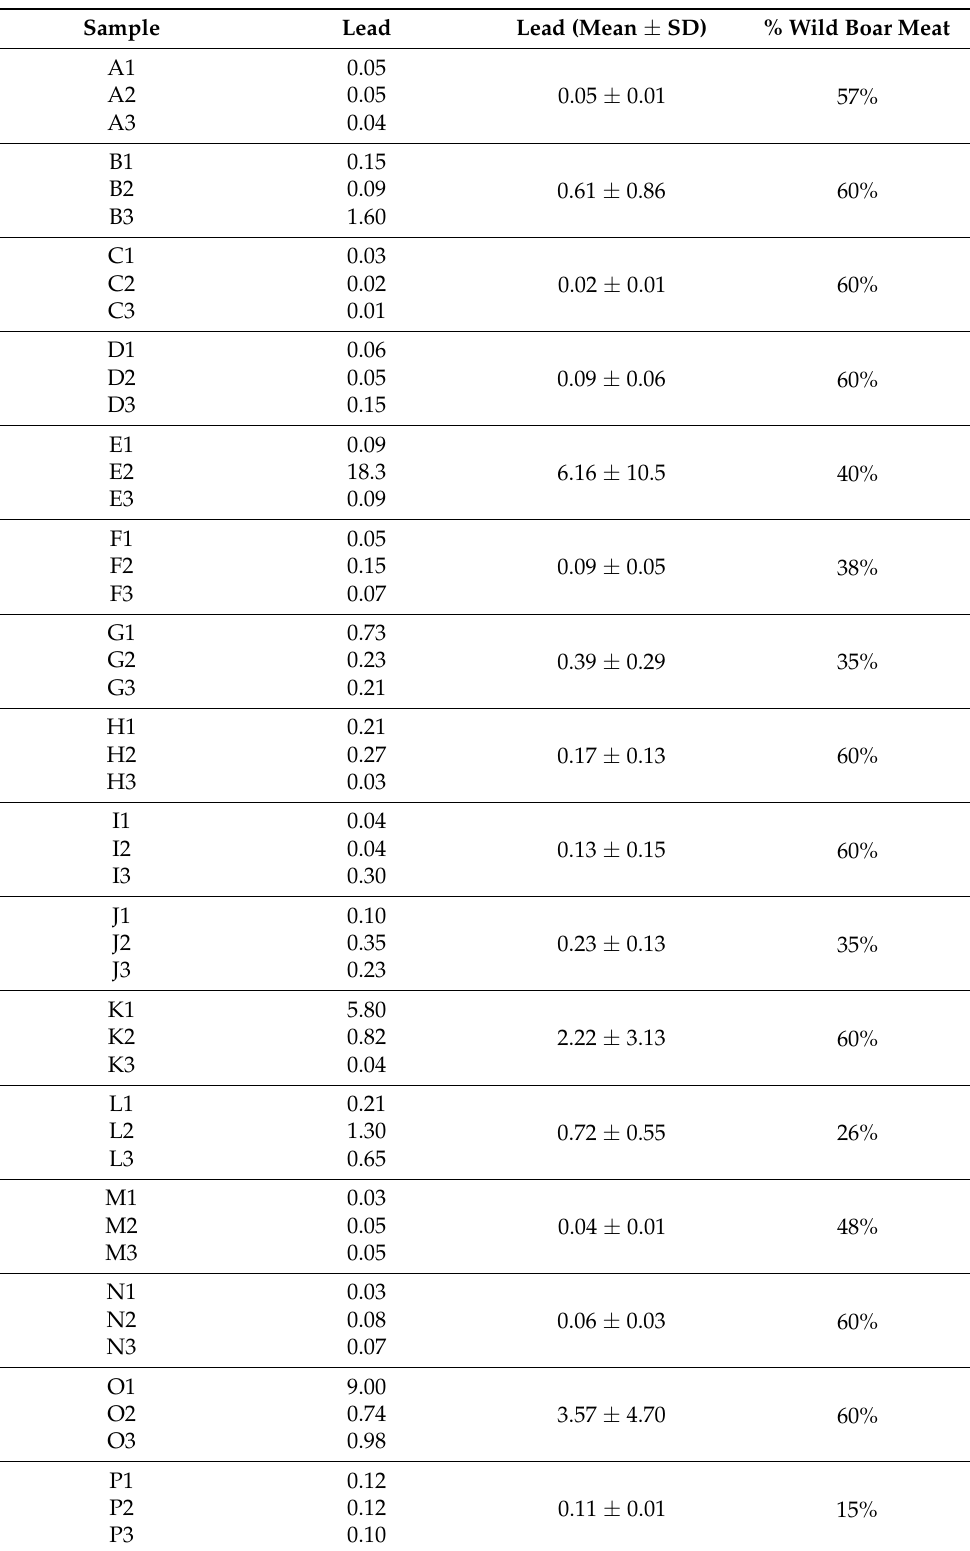
Table 1. Lead levels (mg/kg) detected in wild boar rag ù